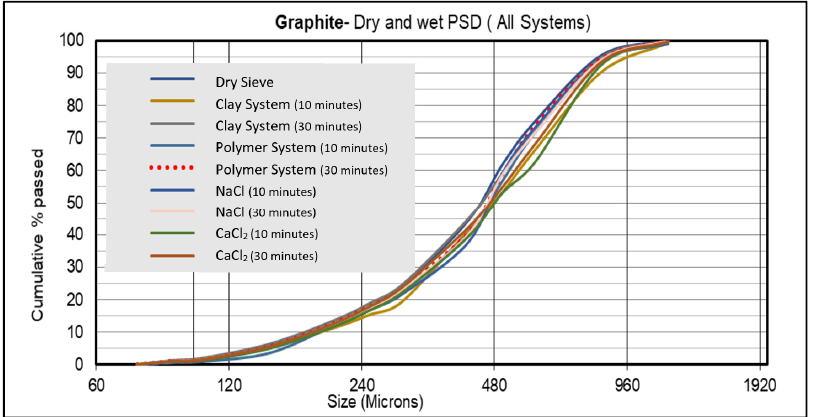
Figure 3. Dry and wet PSD of graphite in the four carrier fluid systems with 10 and 30 min shearing intervals.